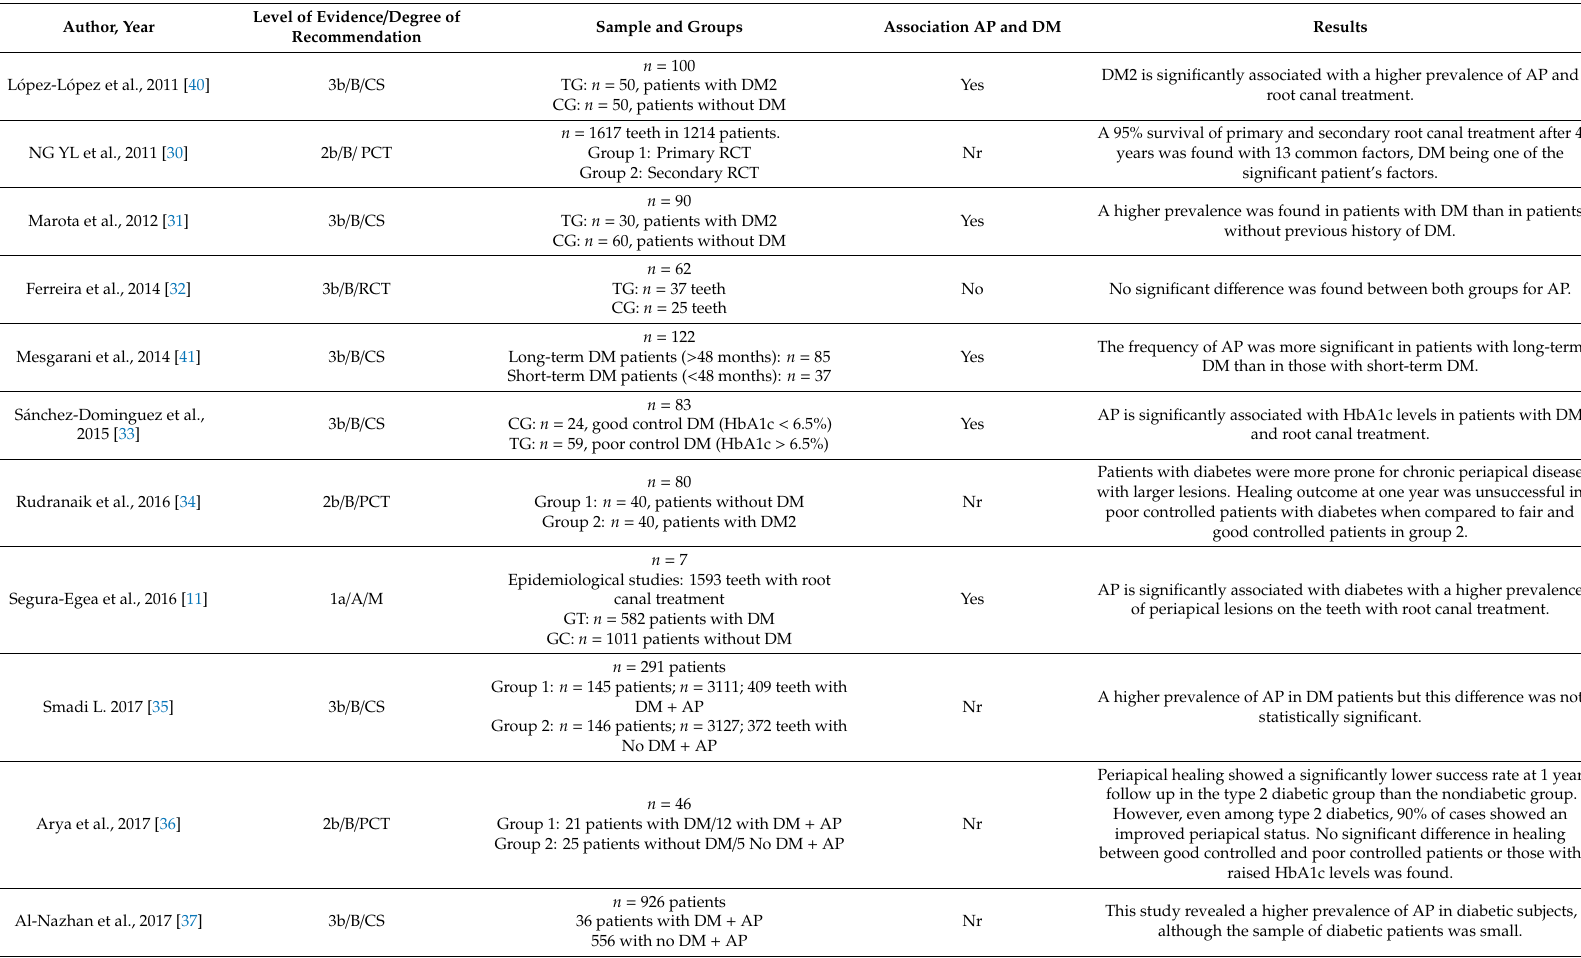
Table 2. Main features of human studies included on the